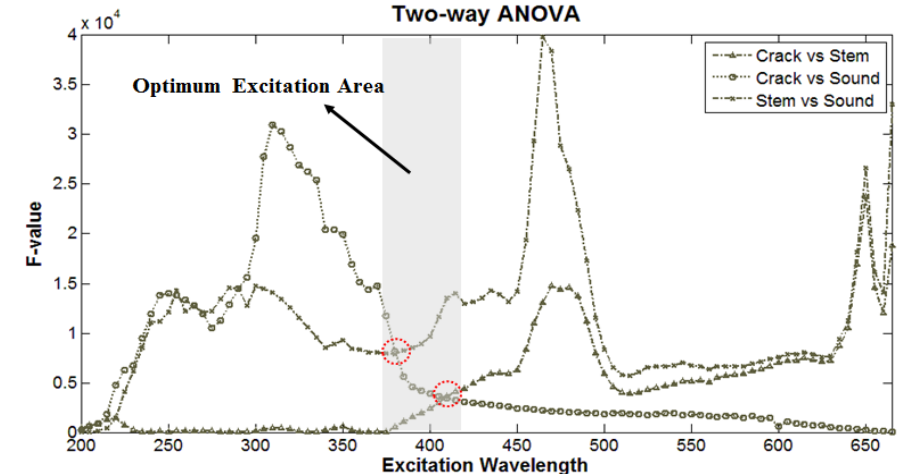
Figure 4. F values of wavelength used for discriminating defect area from sound and stem on the cherry